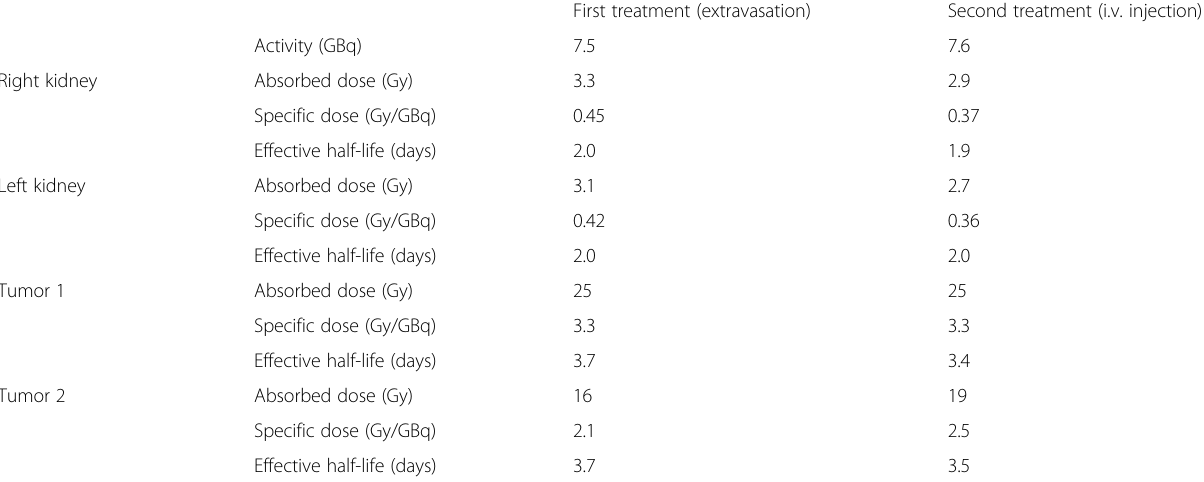
Table 2 Dosimetry of the left and right kidneys and two tumors in the liver First treatment (extravasation) Second treatment (i.v.